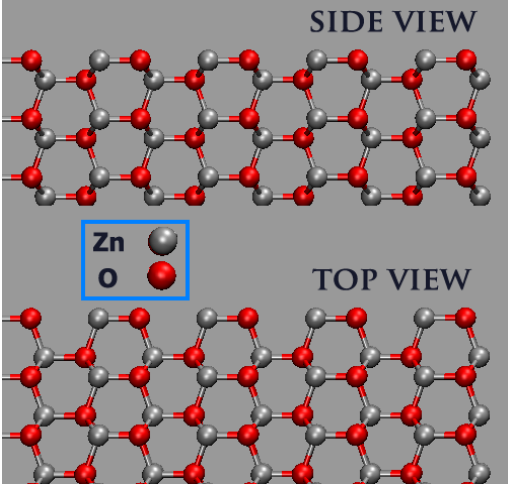
Figure 22. Side and top view of a clean and ideal ZnO (101 - 0)